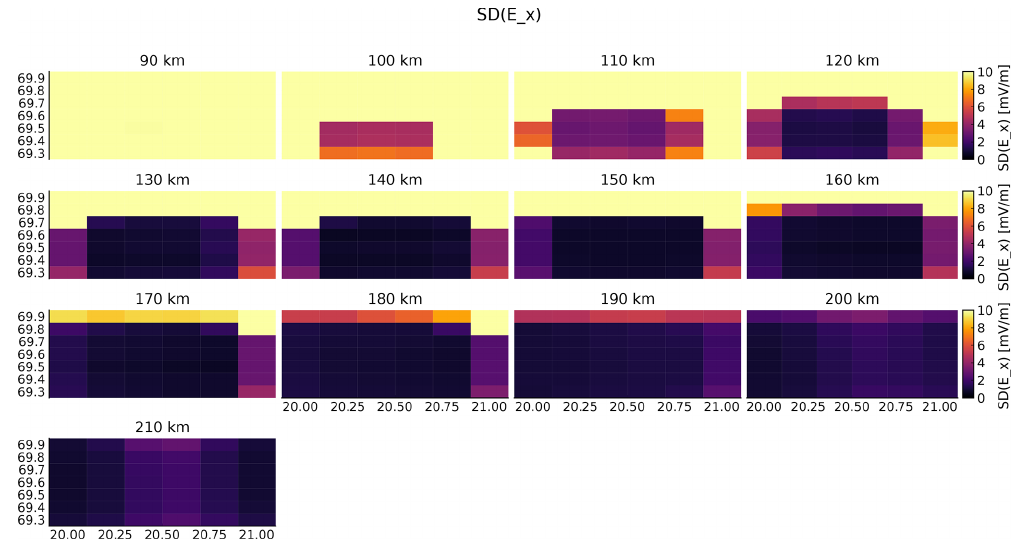
Figure 6. Uncertainty in electric field in local magnetic east direction.